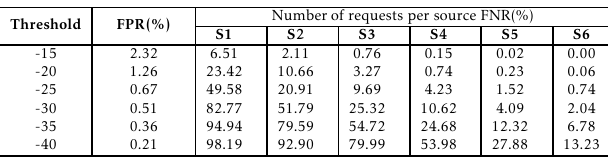
Table 7. Experimental results for the HsMM for the